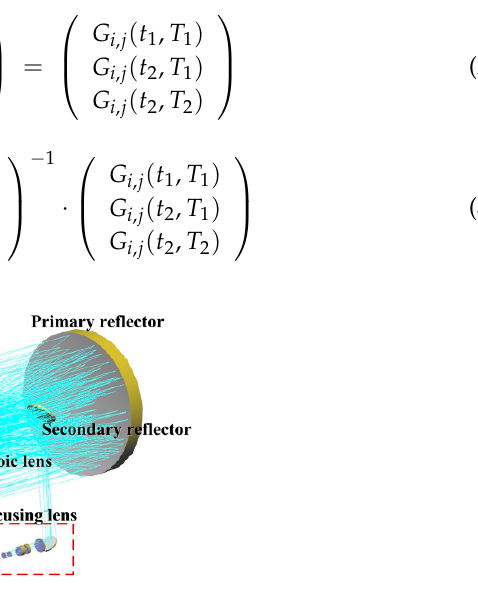
Figure 2. Scheme of near extend-blackbody calibration method.